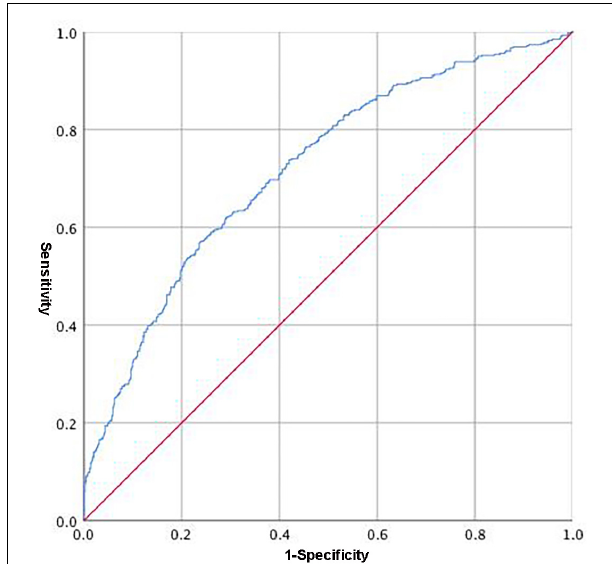
FIGURE 1 | Receiver operating characteristic (ROC) of the integrated variable (Y = 0.205 × 10 − 1 age − 0.595 × 10 − 2 HGB − 0.116 × 10 − 1 ALT + 0.135 FIB) predicting the occurrence of cancer among CAD